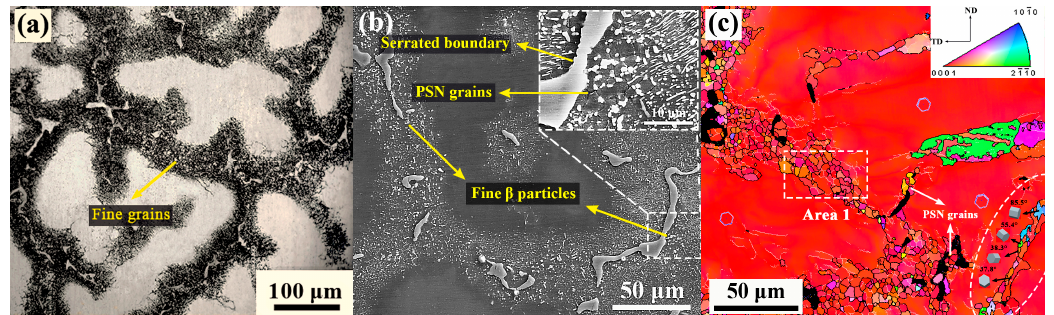
Figure 4. Microstructure of zone A: ( a ) optical microscopy OM, ( b ) SEM, and ( c ) electron backscattering diffraction apparatus (EBSD), where the color key triangle shows the crystallographic orientation of the hexagonal close-packed (HCP) crystal.